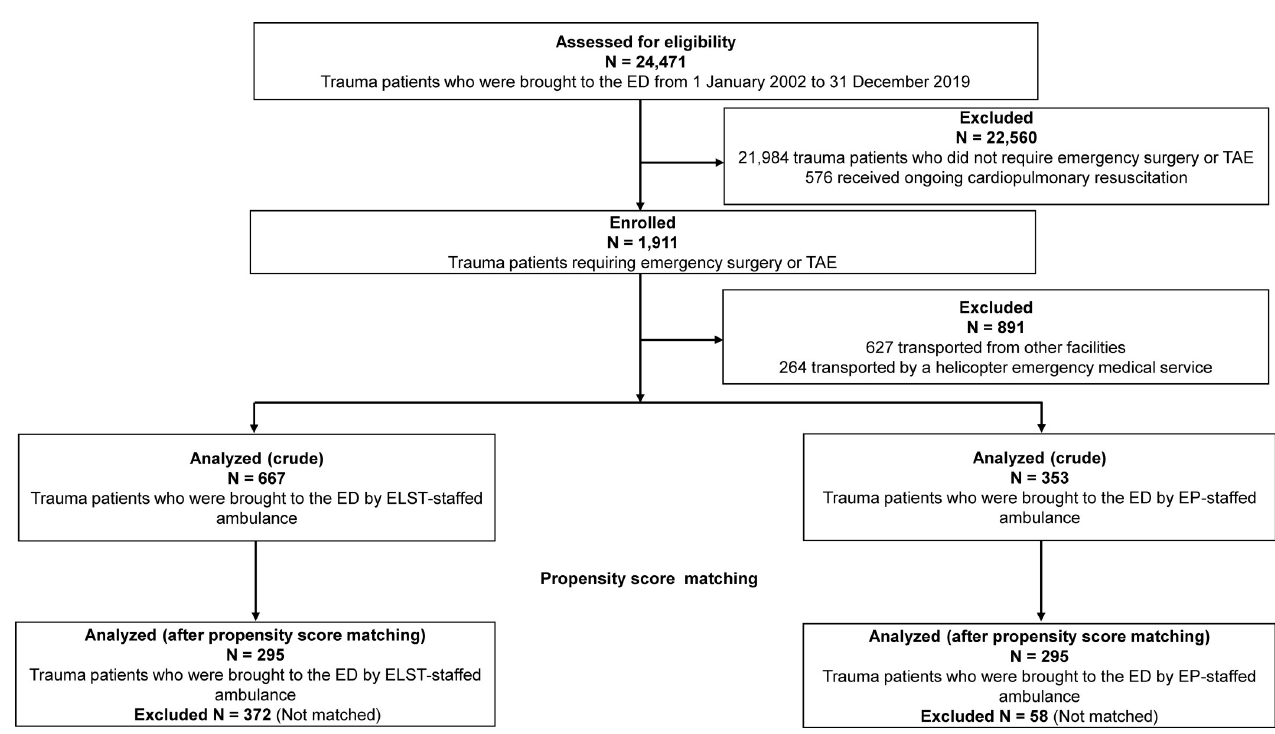
Fig 1. Flow chart showing the selection process for injured patients included in the analyses. ED, emergency department; ELST, emergency life-saving technician; EP, emergency physician; TAE, transcatheter arterial embolization.